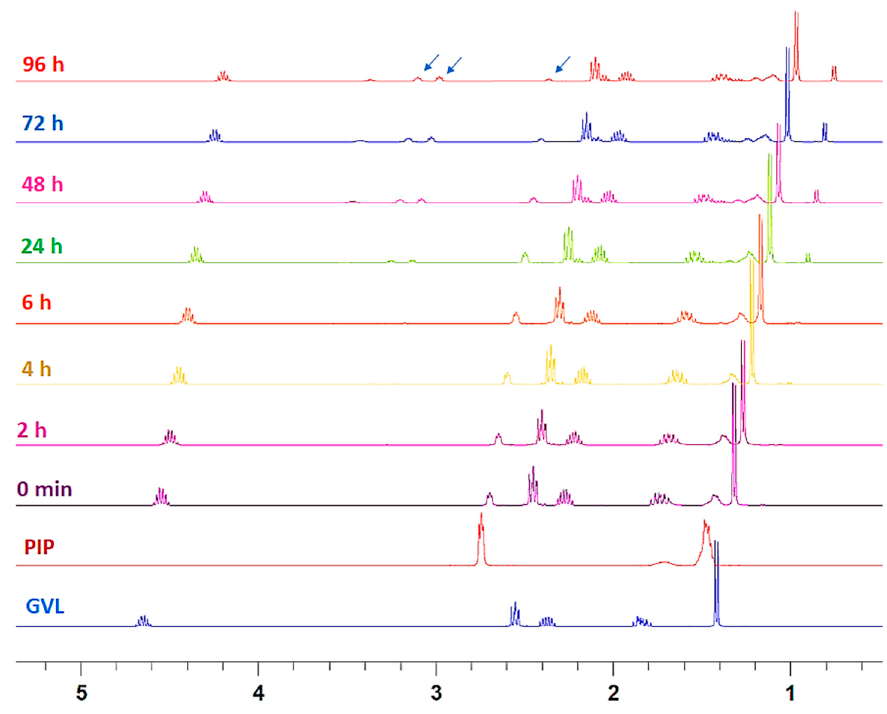
Figure 2. Time-dependent 1 H-NMR study of the formation of piperidide 3a by ring opening of GVL with 20% PIP. Arrows indicate the signals selected for calculation of the percentage of ring opening.